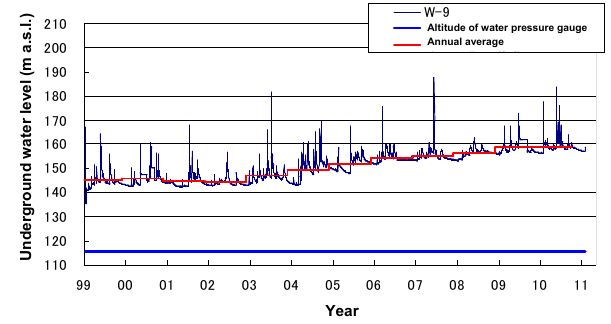
Fig. 7. The water levels measured at W-9 borehole in the period between 1999 and 2010.